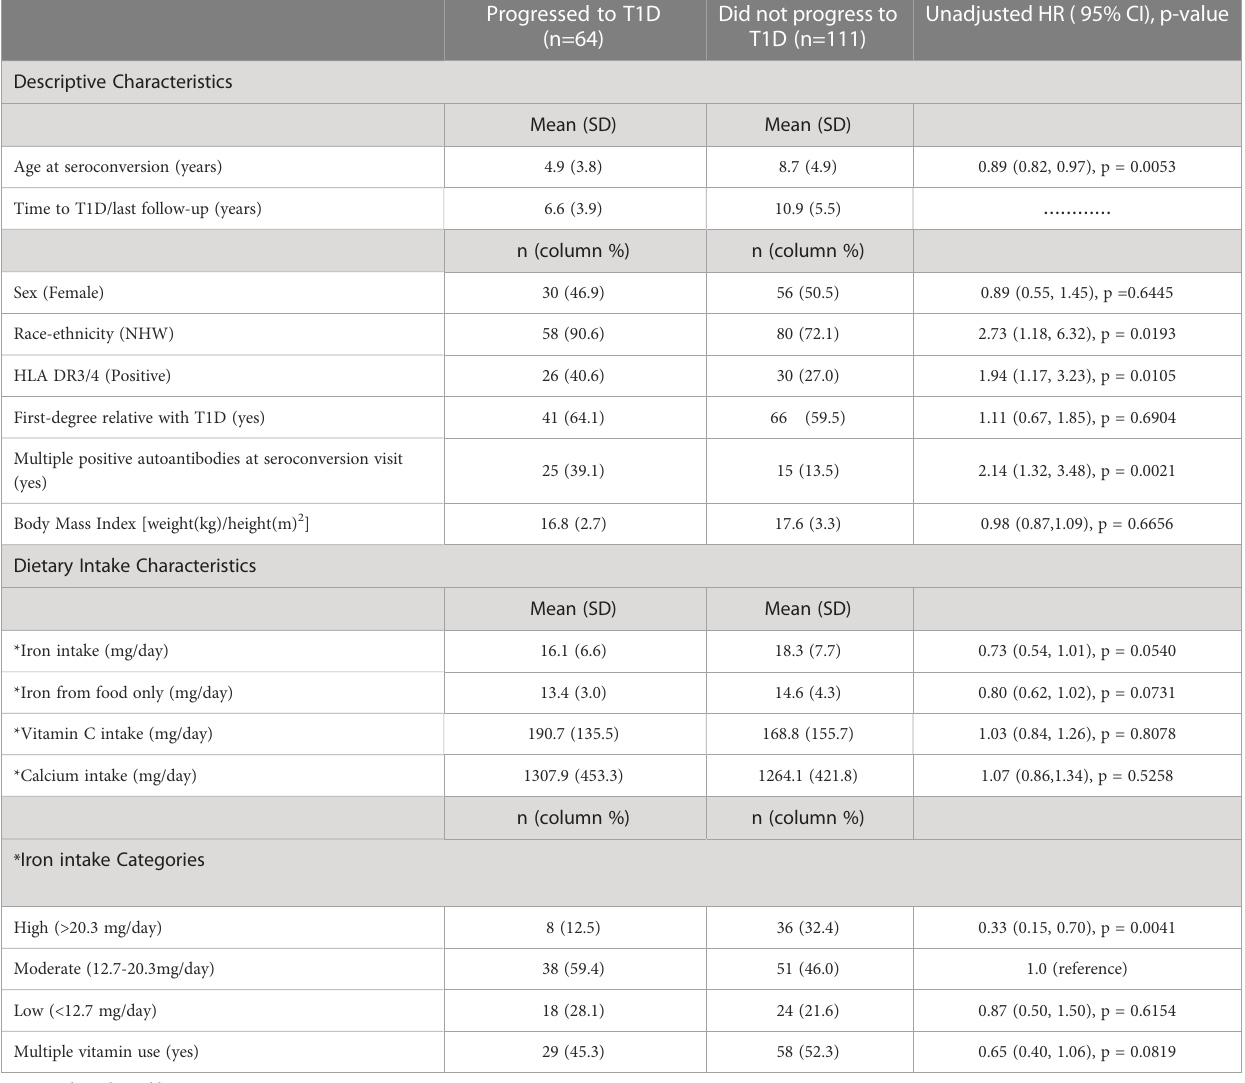
TABLE 1 Descriptive and dietary intake characteristics of children with IA with unadjusted hazard ratios (HR) for progression to T1D.